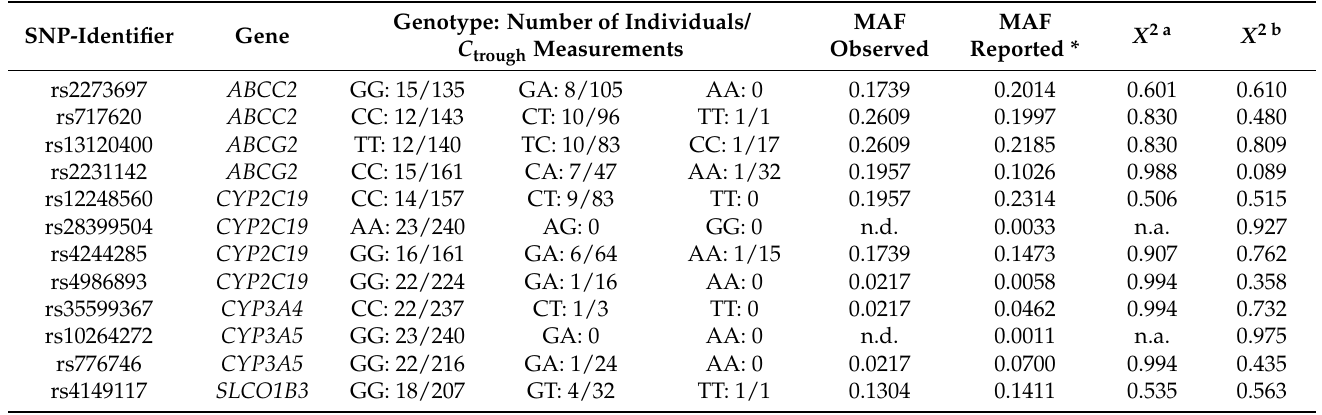
Table 3. Summary of the genetic analysis reporting the number of individuals and the number of C trough measurements observed for each genotype ( n = 251; 11 C trough values were excluded because of lacking information on the dose or because an additional dose was administered >2 h after the initial dose within a dosing interval). Reported is the observed MAF, and the results of the X 2